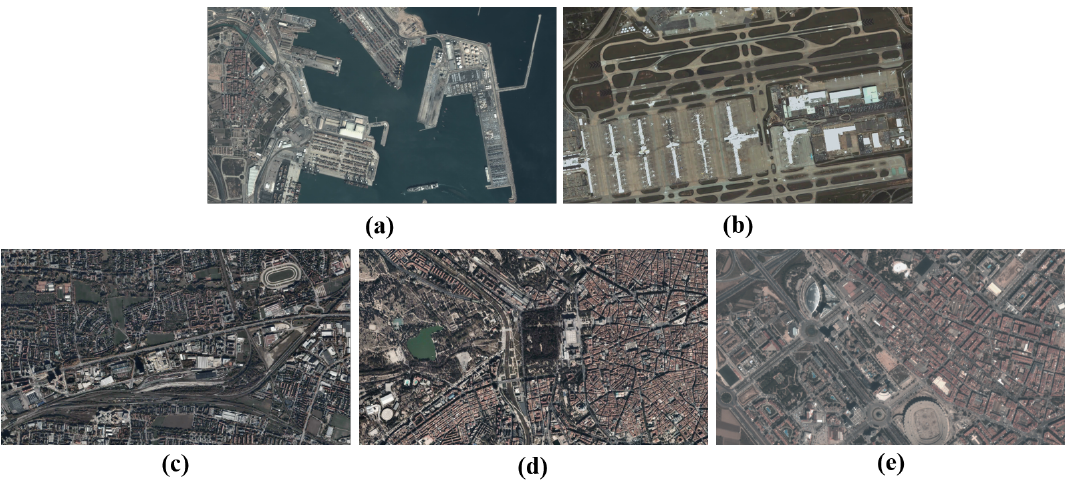
Figure 6. Typical frames of satellite video clips from experimental data. ( a ) Seaport (Valencia);